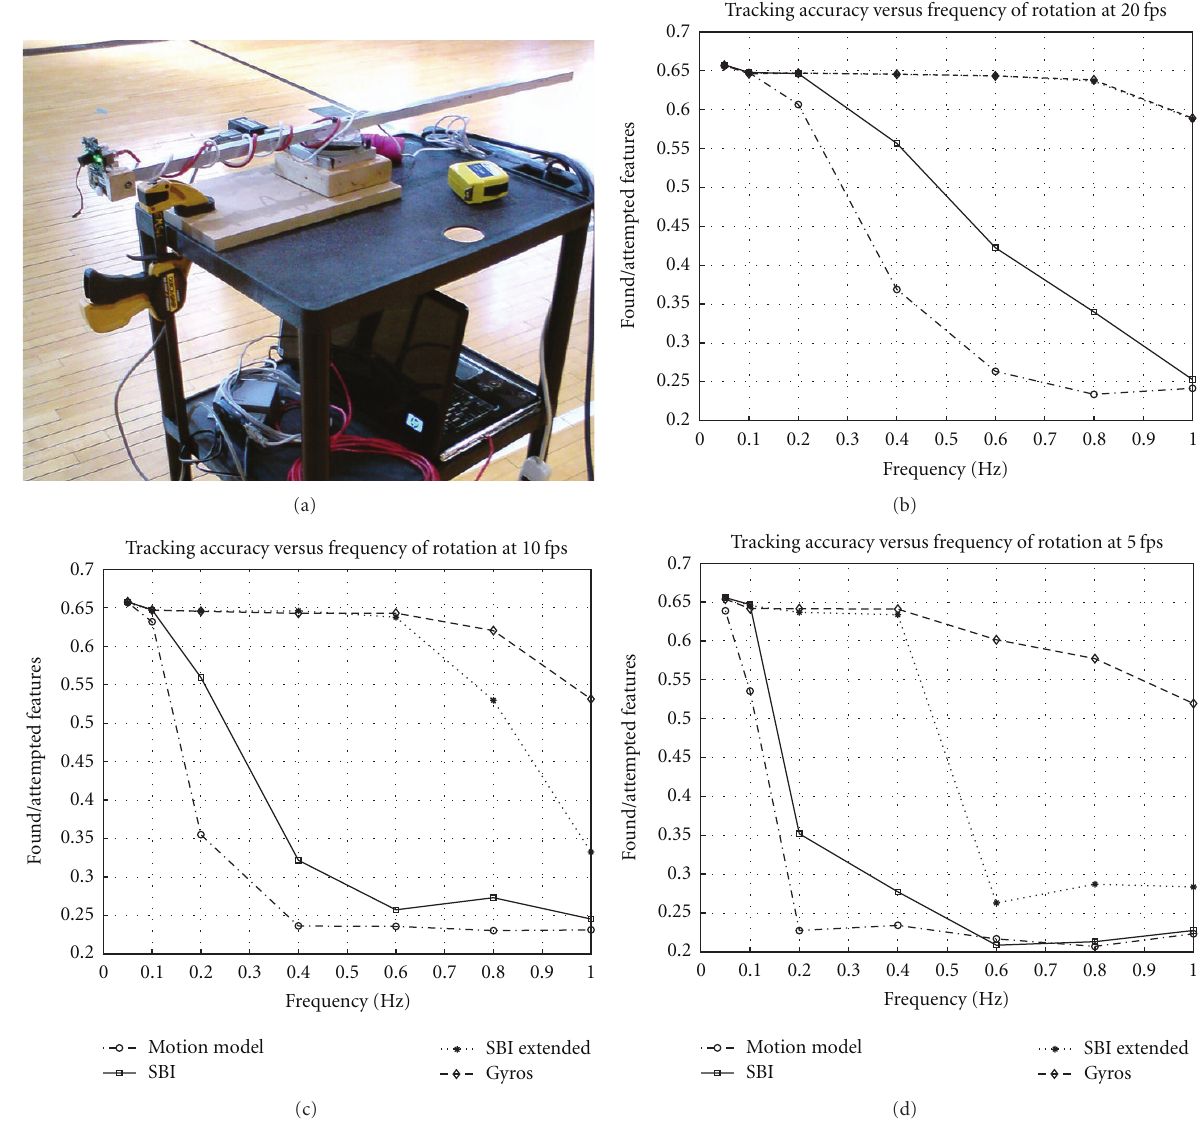
Figure 5: (a) Setup used to capture data for motion simulation. Comparison of the tracking quality for di ff erent methods of estimating camera pose seeded to the Tracker and at di ff erent video frame rates (b) 20fps, (c) 10 fps, and (d) 5 fps.